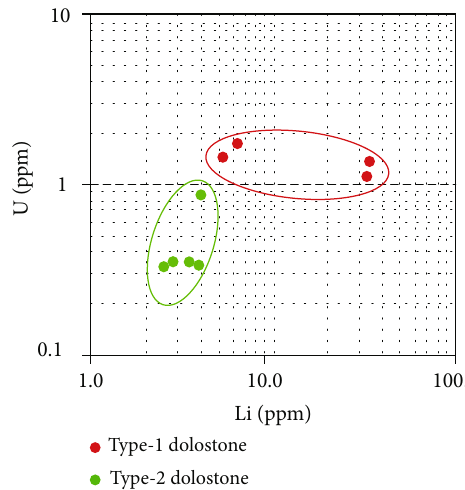
Figure 10: Plot of Li versus U contents for submember Ma5 Ordovician Majiagou Formation in the northwestern Ordos